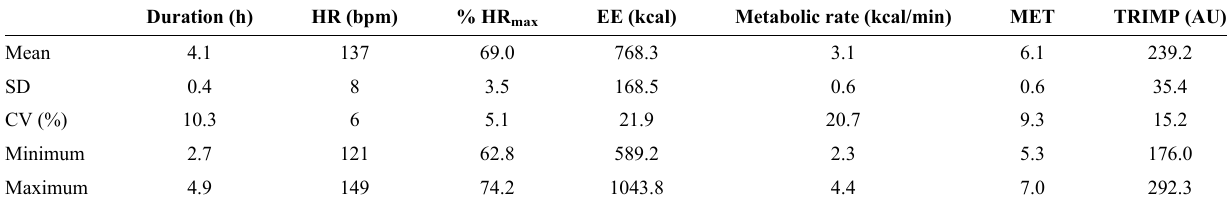
Table 2 - Characterization of artistic gymnastic training